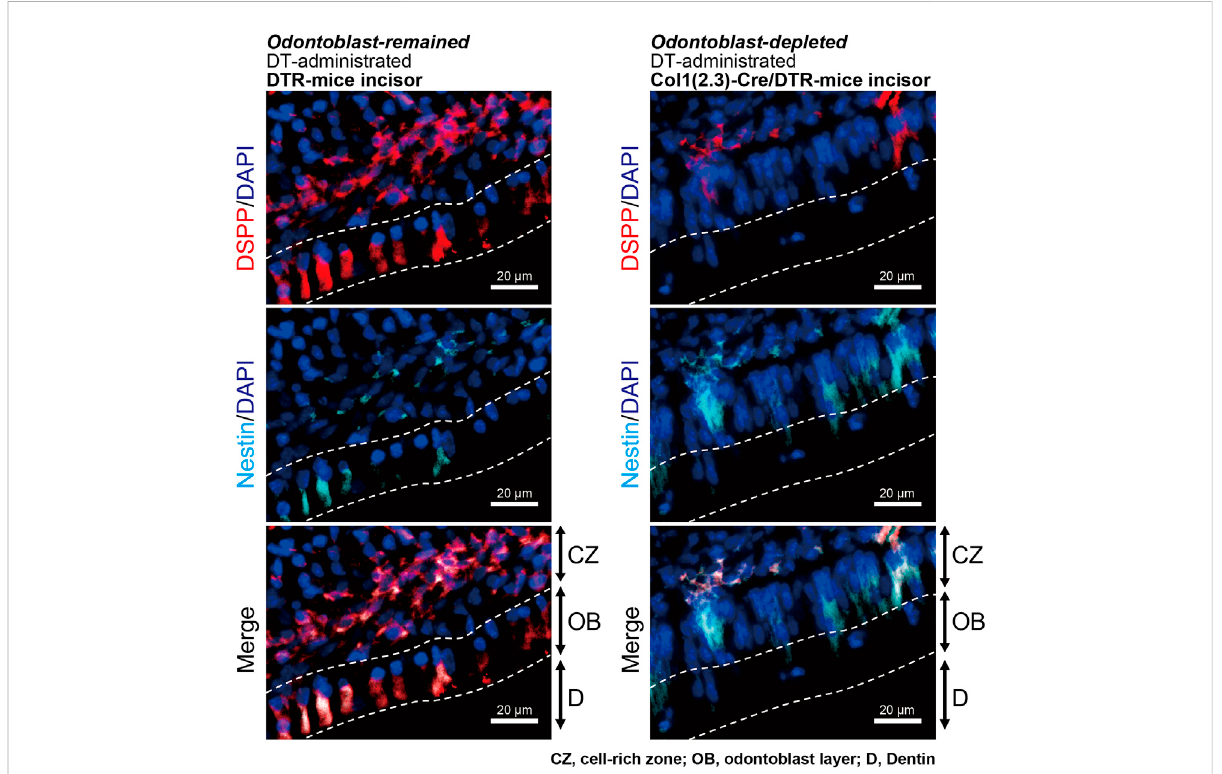
FIGURE 7 Observation of odontoblast-speci fi c makers in incisors of DT-injected DTR-mice and Col1 (2.3)-Cre/DTR-mice after performing a series of measurements of nociceptive scores. Immuno fl uorescence analysis using DT-administered DTR-mice (as control; left panels) showed that DSPP- positive cells (red) were localized in both the cell-rich zone (CZ) and odontoblast (OB) layer in proximity to dentin (D). Nestin-positive odontoblasts (blue)werealsoobservedinbothCZandOB(leftpanels).AnalysisusingCol1(2.3)-Cre/DTR-mice(rightpanels)showedthatDSPP-positive(red) and nestin-positive cells (blue) were not observed in the OB layer. Scale bars, 20 μ